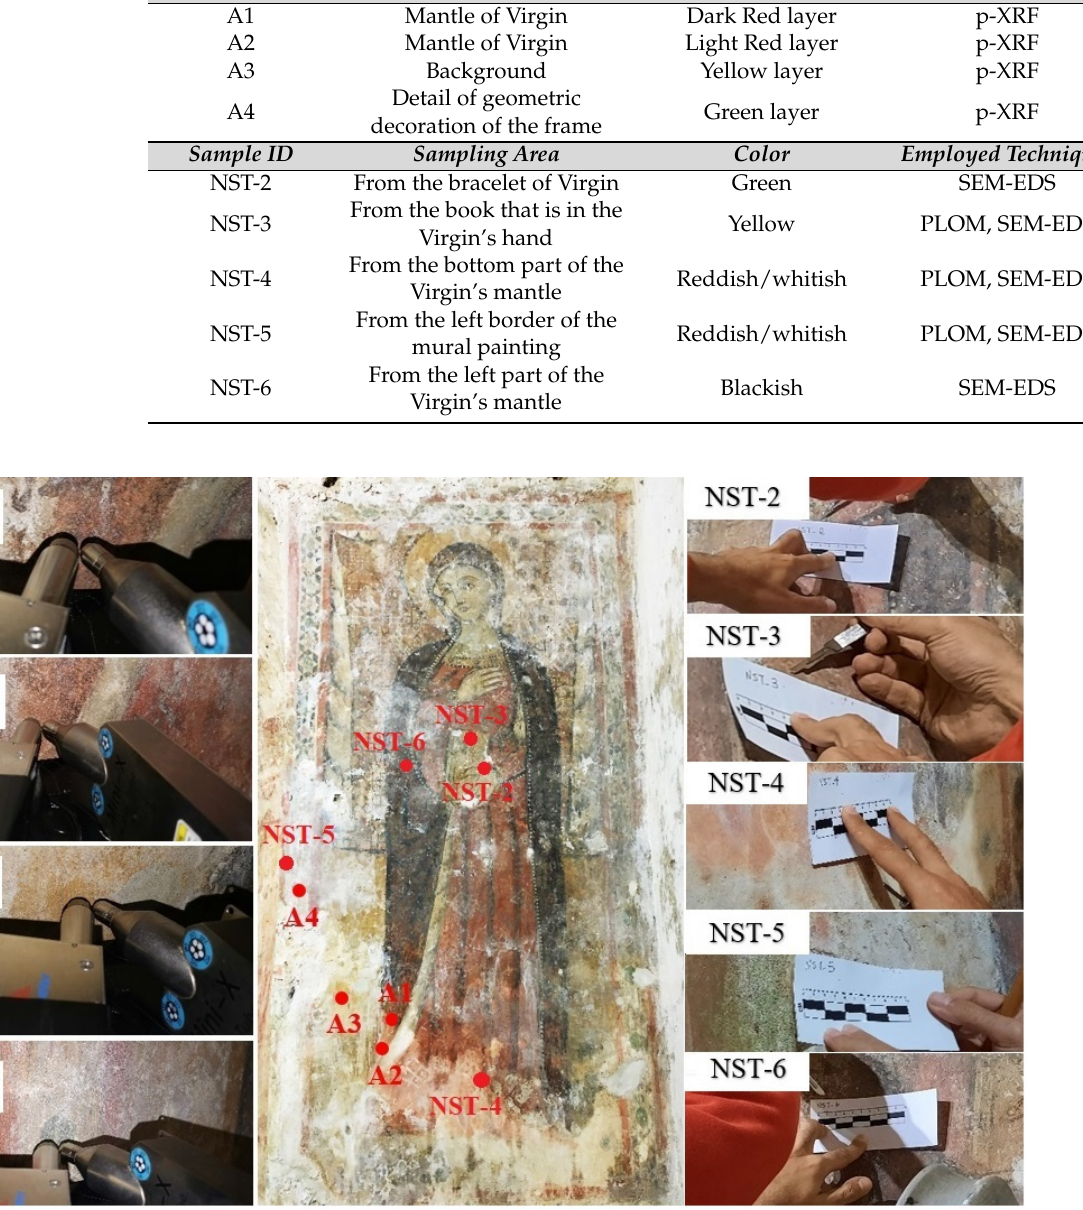
Figure 2. Sampling points for the Mural painting depicting the “Virgin” by in situ methods (ID: A) and laboratory-based analysis (ID: NST). Table 1. Mural painting depicting the “Virgin”: an overview of areas investigated and sampled both with in situ and laboratory-based methods.